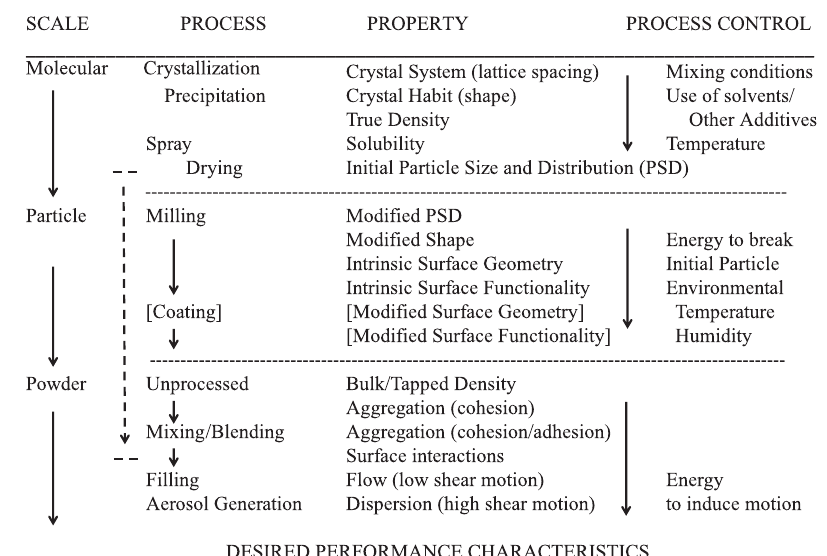
Fig. 10 Properties with respect to scale of scrutiny of a pharmaceutical dry powder aerosol formulation and the processes and variables that must be controlled to optimize desired performance characteristics with respect to quality, safety and